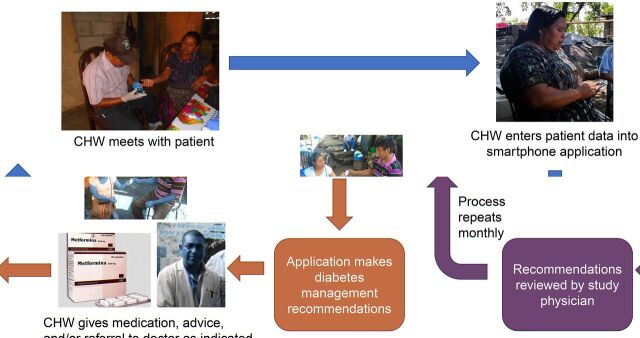
Overall Model for Sustainable Rural Diabetes Care Program Led by Community Health Workers, Guatemala